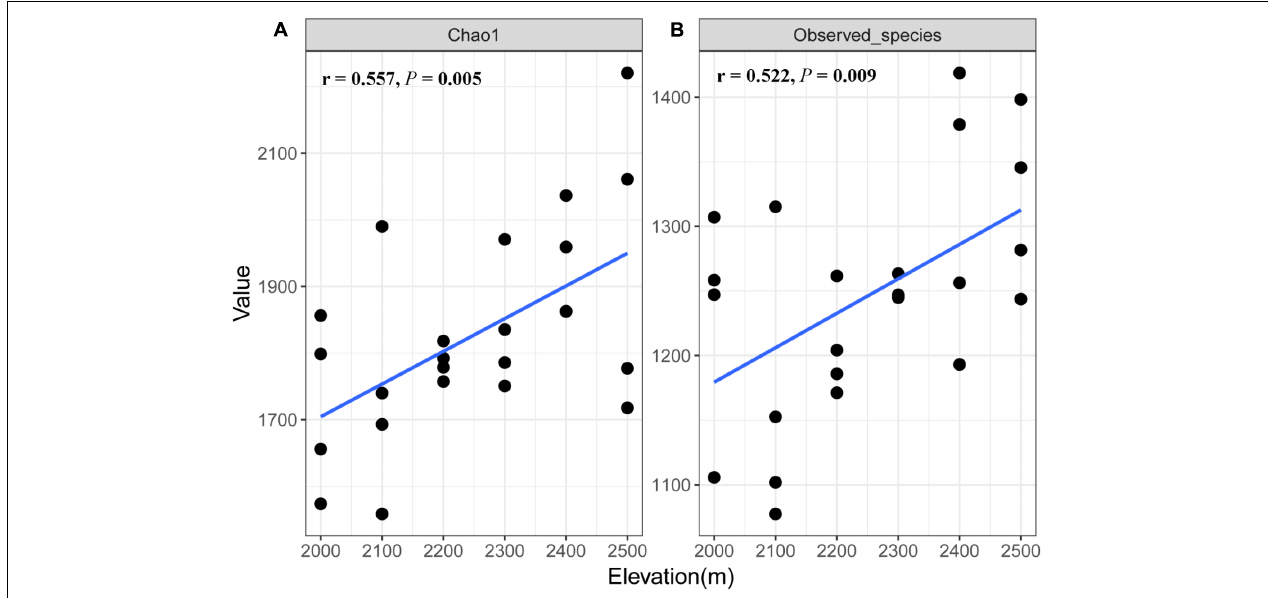
FIGURE 1 | Relationship between fungal Chao1 (A) value and richness (B) and